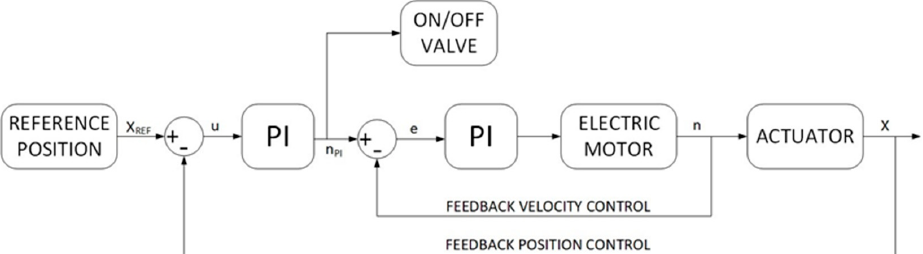
Figure 6. Electro-hydraulic control scheme.